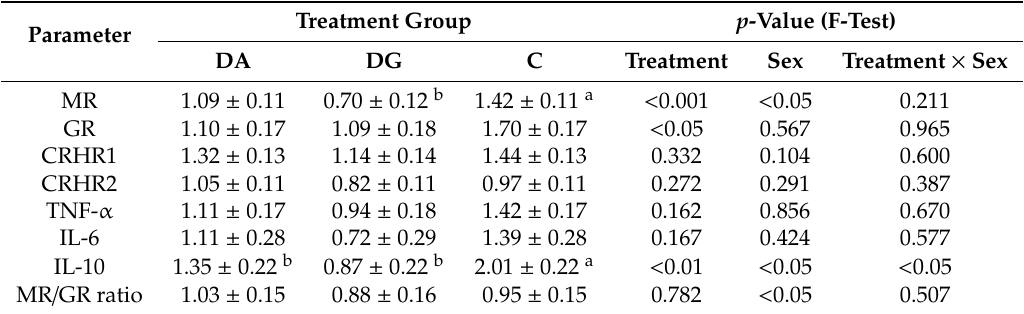
Table 4. Relative mRNA expression of HPA-related parameters and cytokines in the amygdala of piglets of the di ff erent treatment groups. Parameter